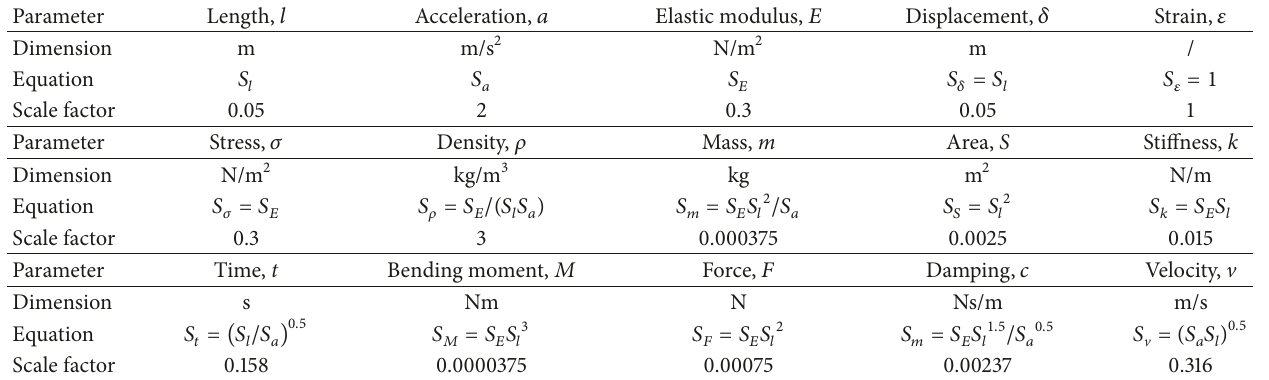
Table 1: Control scale factors for the designed bridge